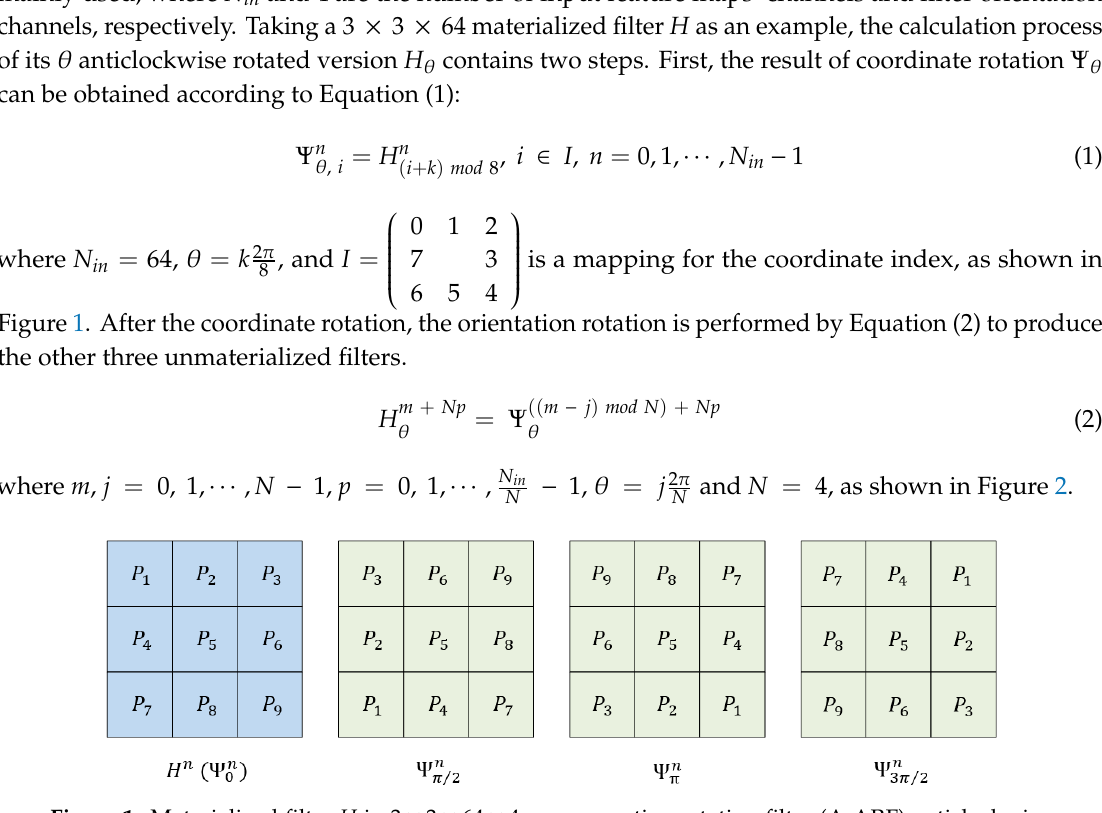
Figure 1. Materialized filter H in 3 × 3 × 64 × 4 average active rotating filter (A-ARF) anticlockwise rotates three times to produce the result of coordinate rotation.